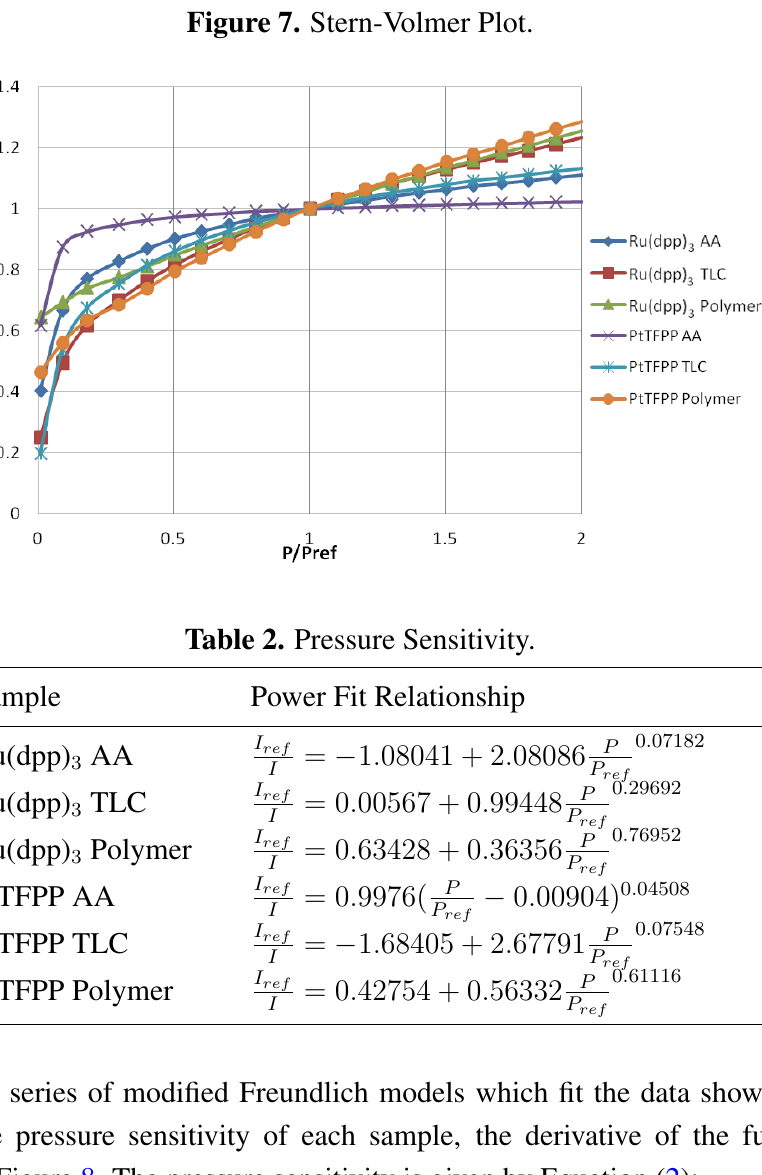
Figure 7. Stern-Volmer Plot.